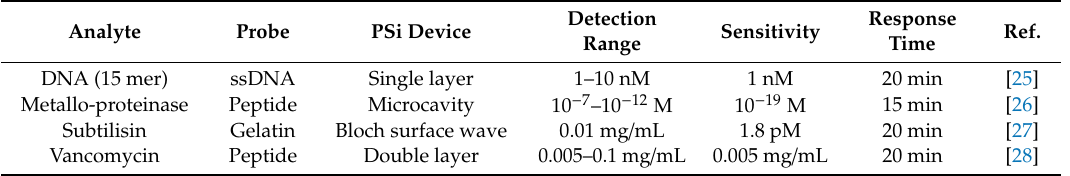
Table 1. Examples of detection of di ff erent biomolecules using PSi optical biosensors. Adapted from Ref.